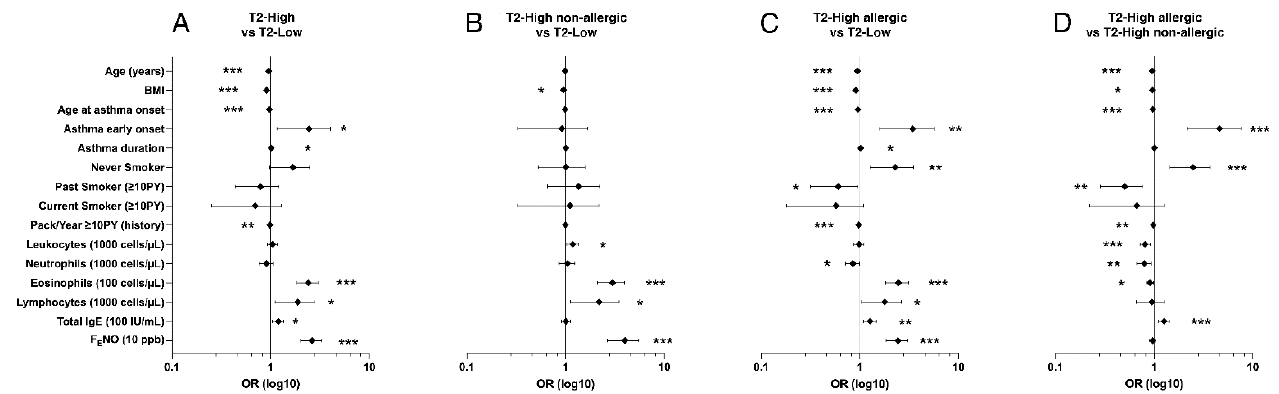
Figure 2. Forest plots of Odds Ratios ± 95% CI concerning demographic characteristics with significant differences between phenotypes at univariate analysis. Type 2 low is considered the reference in panels ( A – C ); Type 2 high non-allergic is considered the reference in panel ( D ). * = p < 0.05; ** = p < 0.01; *** = p < 0.001.